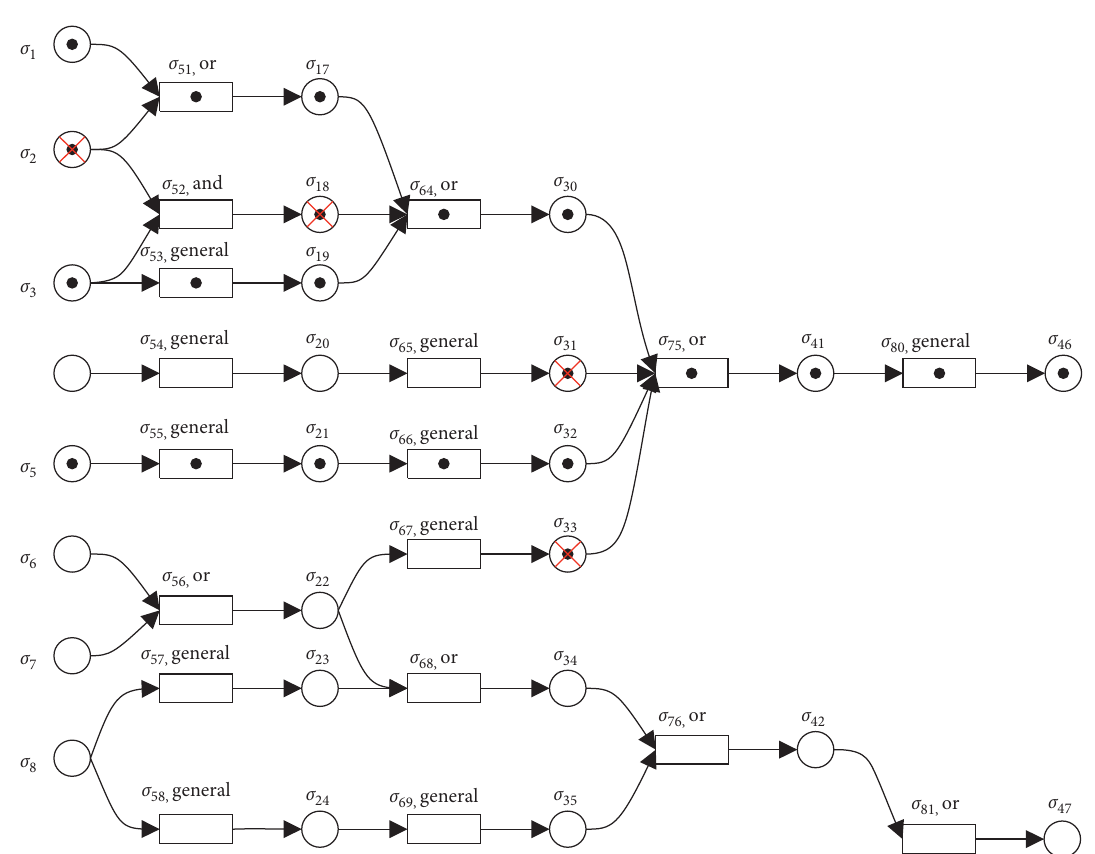
Figure 8: Backward fault abductive